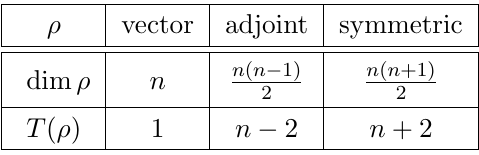
Table 2 . Dimension and indices of some basic SO( n )